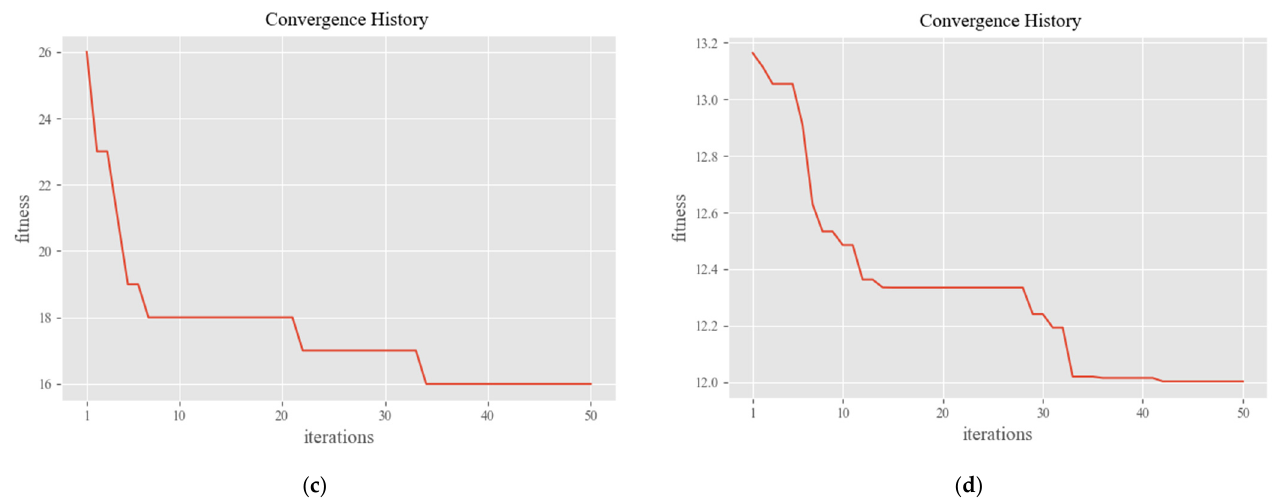
Figure 17. The convergence history of the SSA for the four objective functions. ( a ) Objective function fit 7 (for voltage variation), ( b ) Objective function fit 8 (for sequence voltage unbalance), ( c ) Objective function fit 6 (for number of changes in tap position), ( d ) Objective function fit 9 (for comprehensive optimization).